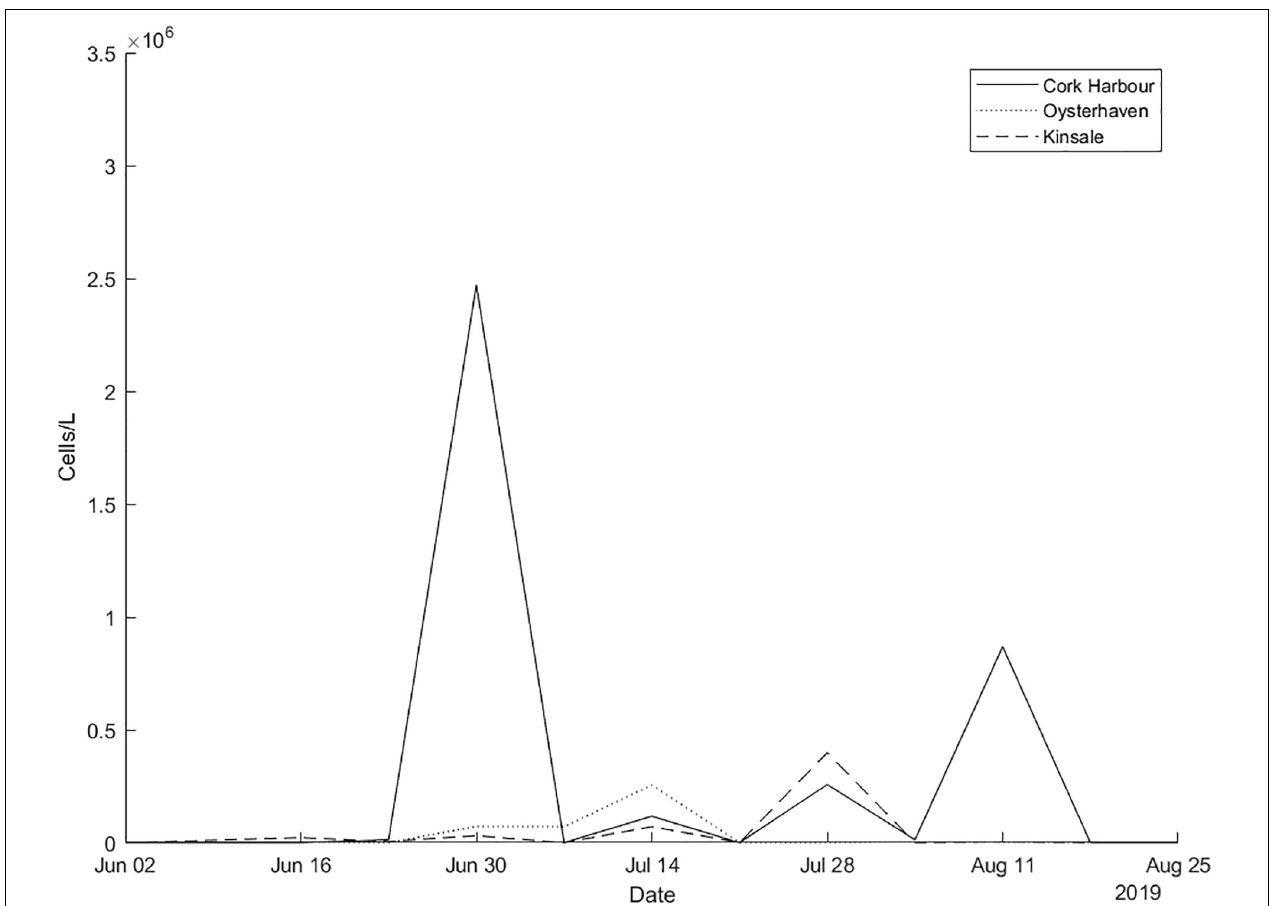
FIGURE 5 | In situ Karenia spp. cells/L counts for inshore stations in Cork Harbour, Oysterhaven, and Kinsale from the national monitoring programme June–August 2019.